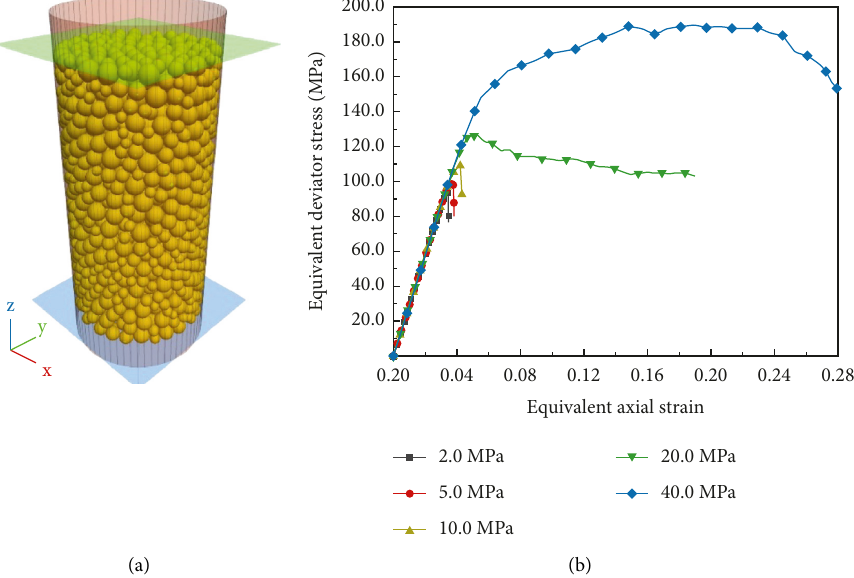
Figure 3: Simulation of triaxial test: (a) the loading diagram and (b) the equivalent deviator stress-equivalent axial strain